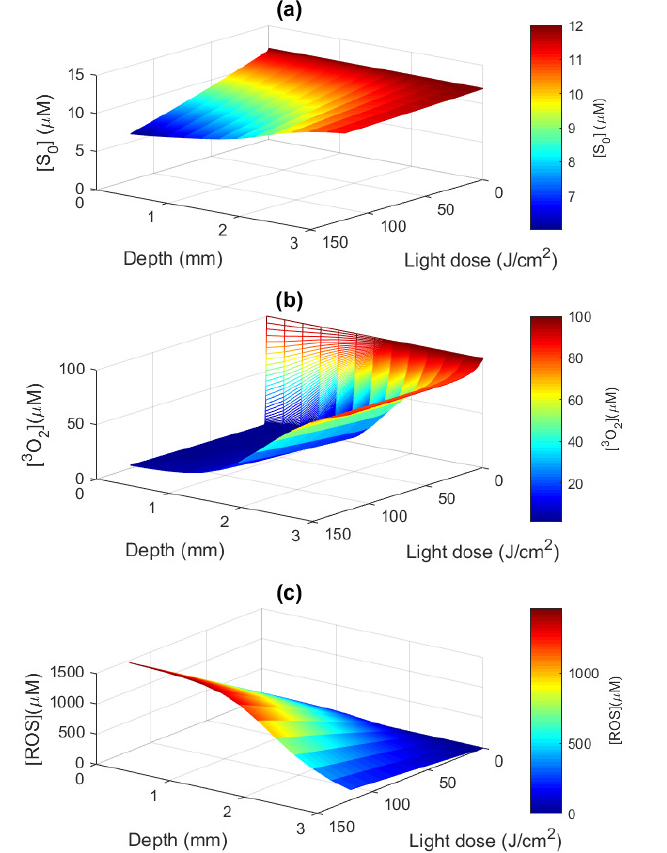
Figure 4. Dynamic variations of: ( a ) [ S 0 ] ; ( b ) [ 3 O 2 ] ; and ( c ) [ ROS ] as functions of depth and delivered light dose for a fluence rate of 75 mW/cm 2 and a total light dose of 150 J/cm 2 .